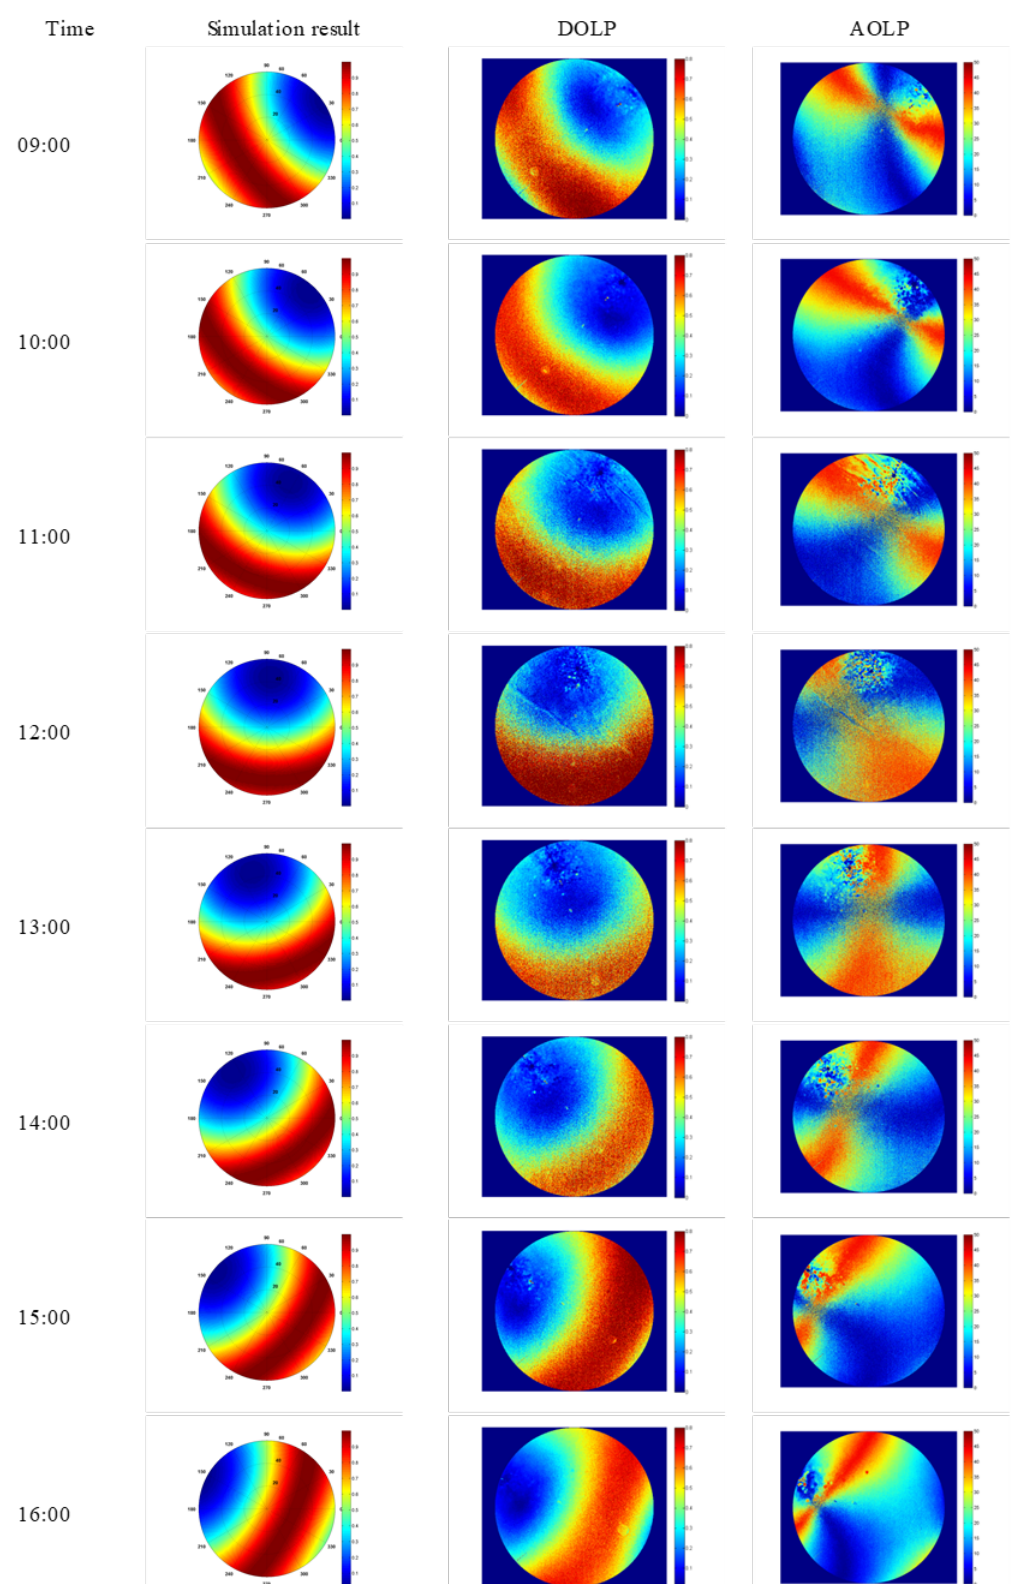
Figure 3. Daily variation of DOLP and AOLP of skylight (March 13, 2019, Peking